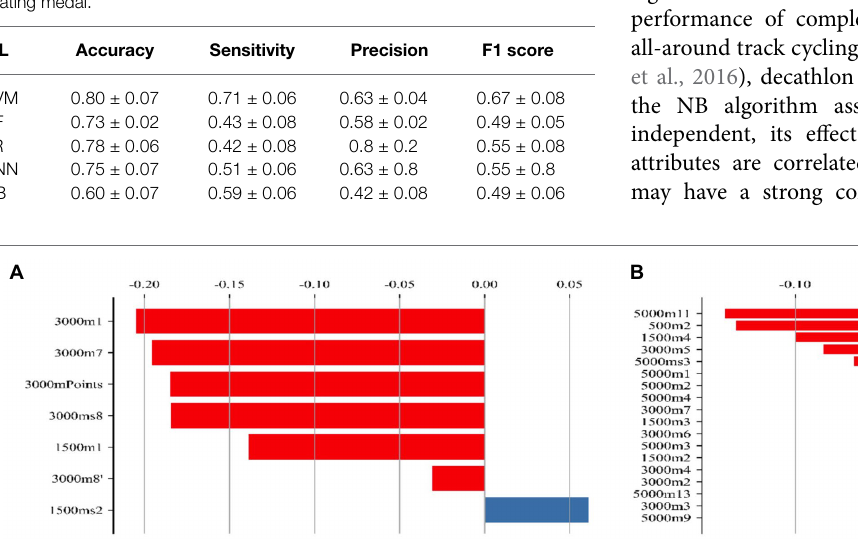
FIGURE 5 | Weight of feature. (A) The feature weights of the 5,000 m race model; (B) the feature weights of the medal